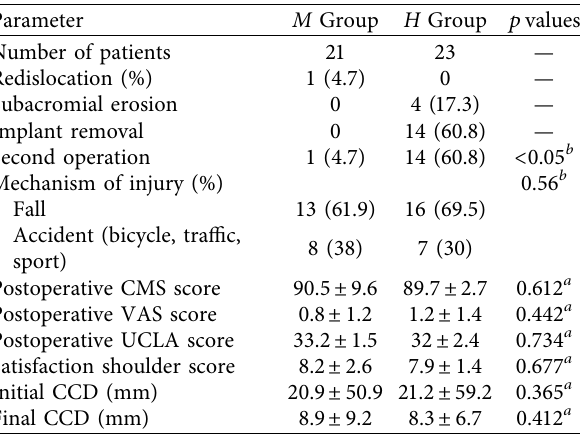
Table 2: Comparison of injury-related data, VAS and CMS score between MTRL and HP